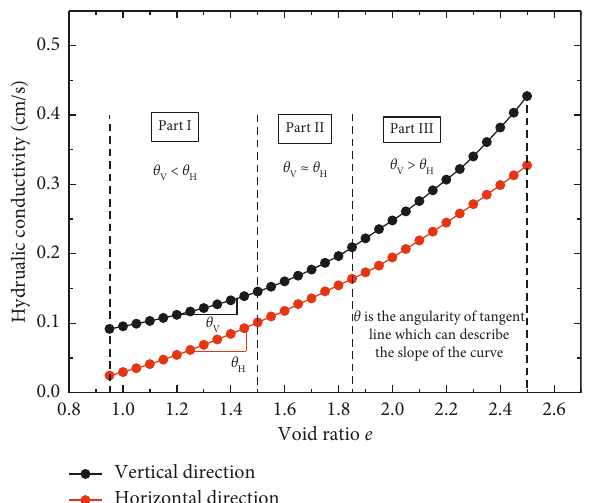
Figure 17: Vertical hydraulic conductivity vs horizontal hydraulic conductivity under four-particle